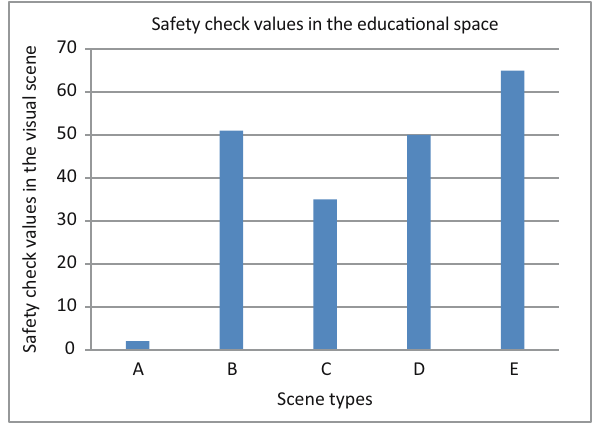
Figure 3: Shows the safety check values in the fi ve visual